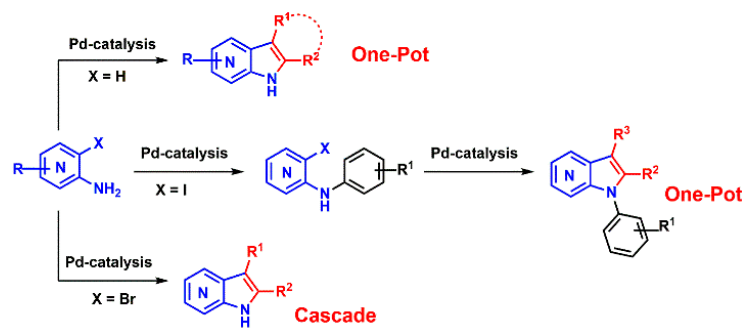
Figure 1. Novel metal-catalyzed syntheses of N